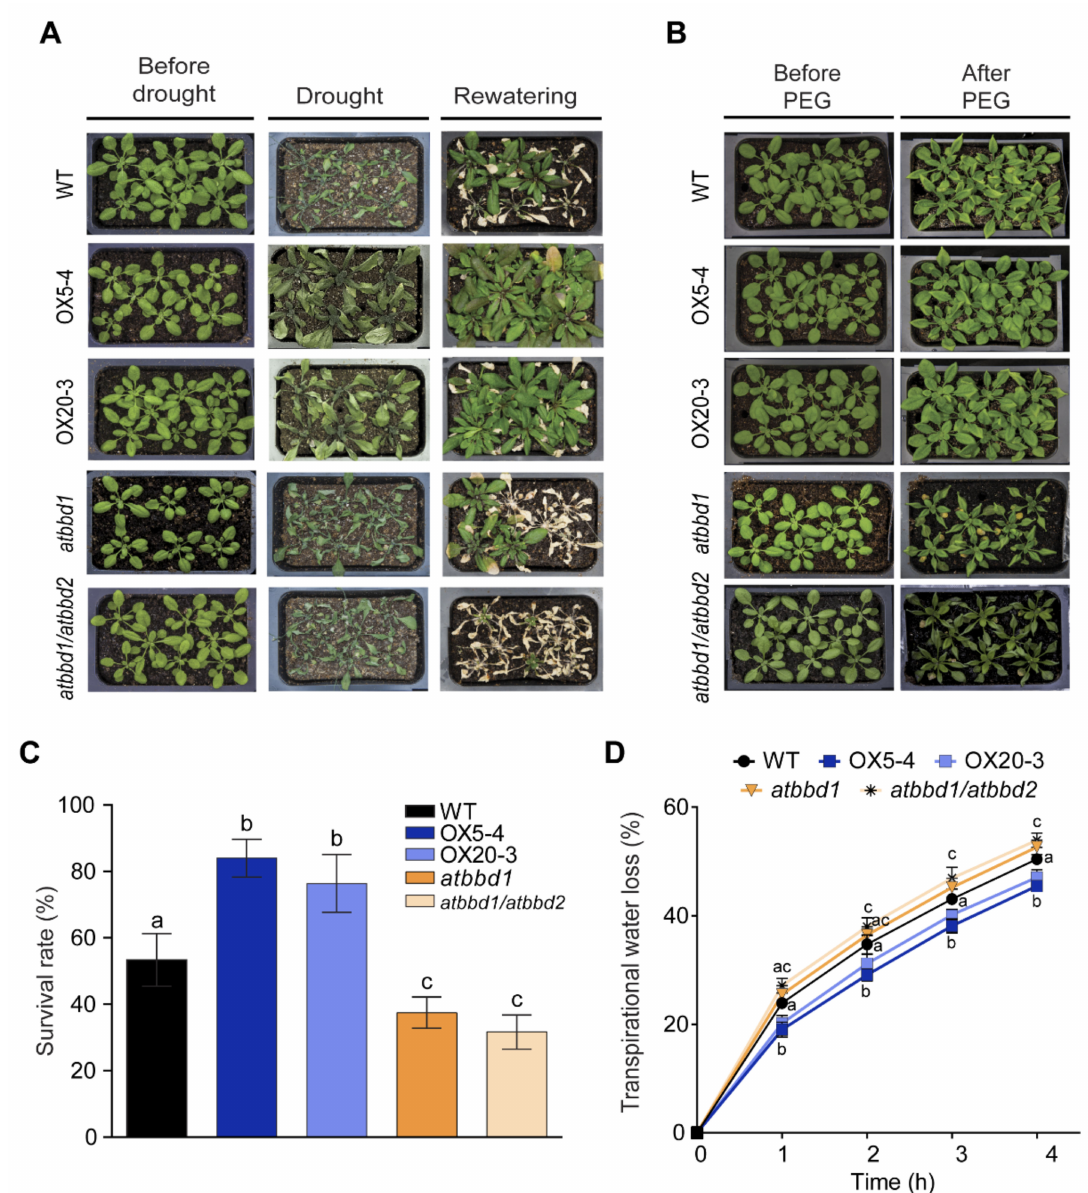
Figure 3. Drought stress response of the WT, two BBD1 -Ox, atbbd1 , and atbbd1/atbbd2 plants. ( A ) Response of the WT, OX5-4, OX20-3, atbbd1, and atbbd1/atbbd2 plants under drought stress conditions. Three-week-old plants were subjected to drought stress by withholding water for 12 days, followed by rewatering for three